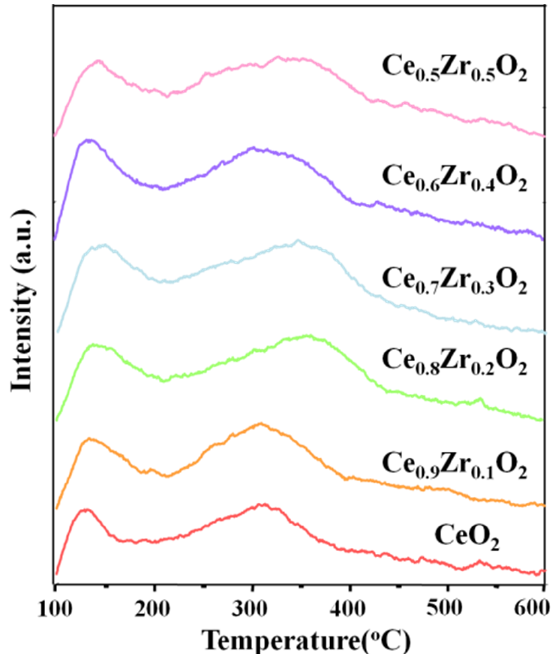
Figure 3. NH 3 -TPD profiles of Ce 1-x Zr x O 2 nanorods.